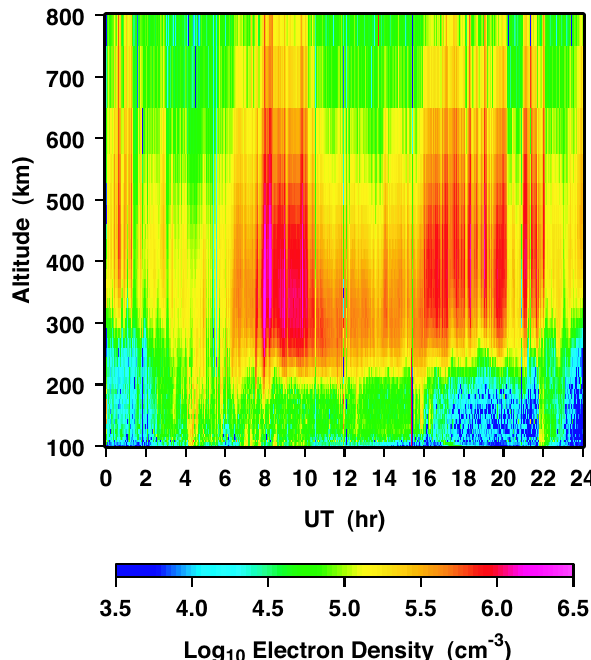
Fig. 1. EISCAT Svalbard Radar (ESR) electron density observa- tions for 19 October 2002 (day 292). Altitude profiles of the iono- sphere above Longyearbyen are shown for a 24-h period; N e is color coded on a logarithmic